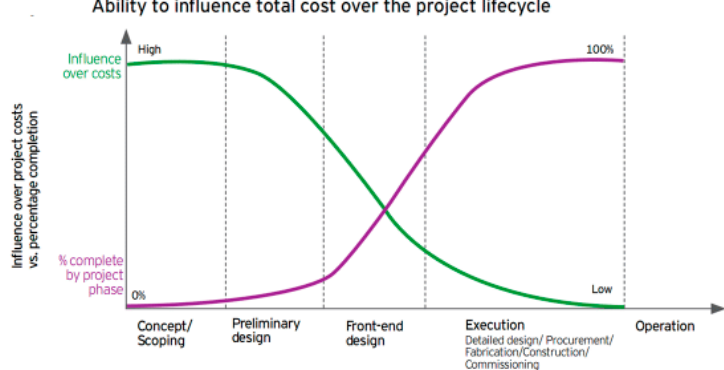
Figure 4. Ability to influence cost over time and the cost of change